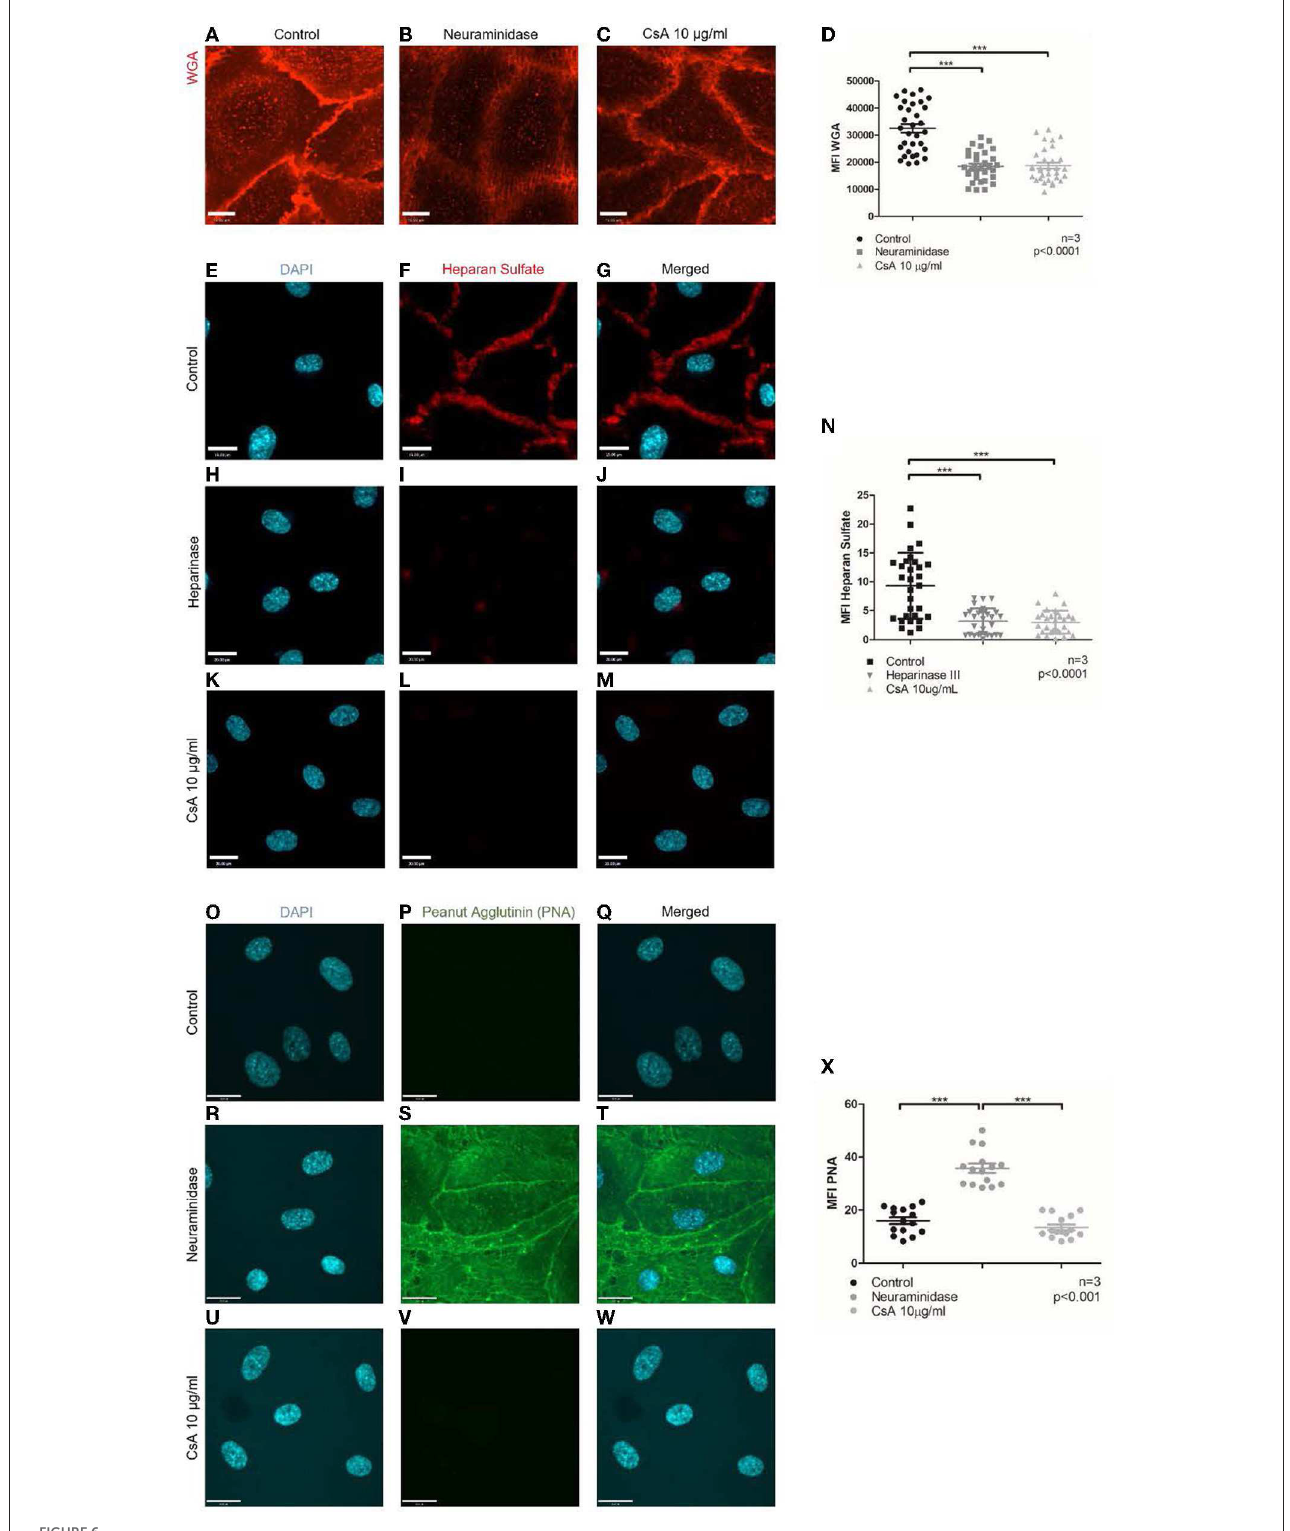
FIGURE6 Cyclosporine causes breakdown of endothelial cell glycocalyx. (A–D) Live cell imaging of blood outgrowth endothelial cell (BOEC) glycocalyx with Alexa Fluor 594-conjugated wheat germ agglutinin (WGA). When compared to BOECs treated with (A) media for 24h (control), BOECs treated with (B) neuraminidase 500 mU/ml for 1h and (C) cyclosporine (CsA) 10 µ g/ml for 24h were less intensely stained with WGA. Mean fluorescence intensity from three sets of experiments with 10 representative images taken per condition (each dot represents 1 image) was measured with ImageJ and summarized in (D) . There was a significant reduction in mean fluorescence intensity of WGA staining on BOECs treated with cyclosporine ( n = 3, *** p < 0.0001, two-tailed t -test). Bar = 22 µ m. (E–X) Heparan sulfate and PNA were detected via immunofluorescence. Control BOECs were treated with media for 24h, BOECs treated with neuraminidase 500 mU/ml for 1h were used as positive control for PNA experiments, and BOECs treated with heparinase III 0.5 U/ml for 30min were used as positive control for heparan sulfate experiments. BOECs were fixed with 2% paraformaldehyde, followed by